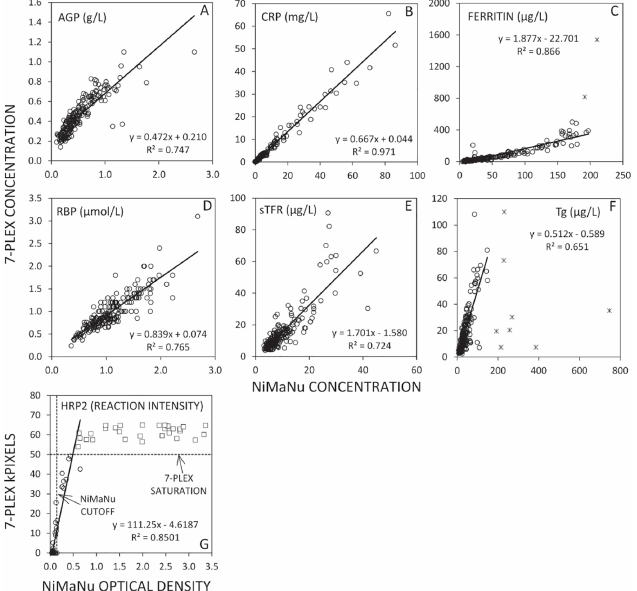
Fig 2. Scatter plots of the 7-Plex results versus NiMaNu conventional immunoassay results. Concentrations of each analyteas measuredin the 7-Plex (x-axes) plotted against concentrations measured using conventional assays (y-axes) for the NiMaNupanel. Solid line is linear least squaresregression(y = mx +b). For ferritin,2 outlierswereexcludedfrom regressionandfor Tg, 9 outlierswereexcludedfrom regression (theoutliersare includedinthe plotsmarkedas x rather opencircles);3 extremelyhighNiMaNuTg values excludedfrom plot. For HRP2,the plot reflectsassaysignalintensityrather thanconcentrationas concentration wasnot availablefrom the NiMaNudataset.Horizontaldottedlineindicatescutoff for positiveresultsbasedon the conventionalimmunoassay andverticallineindicates7-Plexassay resultsbeyondassaysaturation. AGP, α - 1-acidglycoprotein; CRP, C-reactiveprotein;HRP2,histidinerichproteinII; RBP, retinolbindingprotein4; sTfR, solubletransferrin receptor;Tg, thyroglobulin.